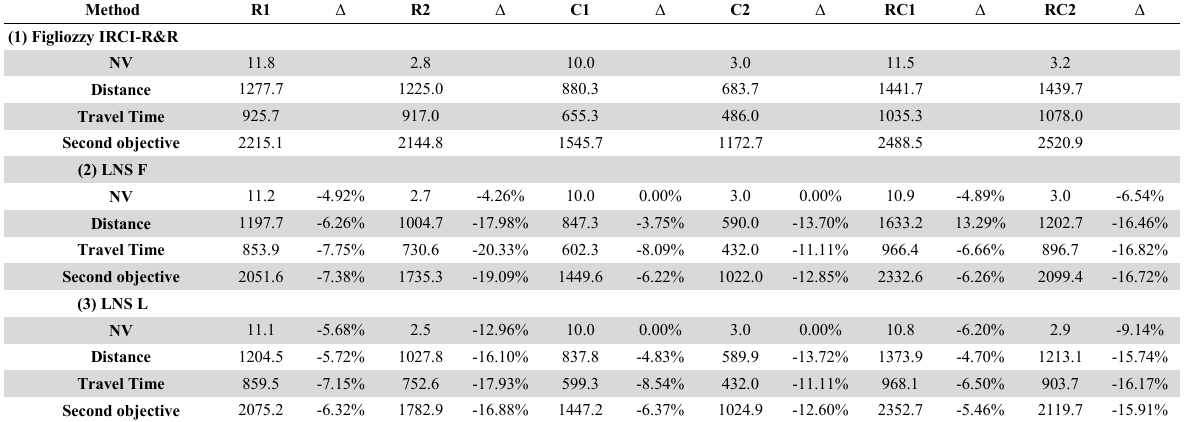
TDVRPTW Average results for 3 instances in Cases Type (b) 100 customers Method